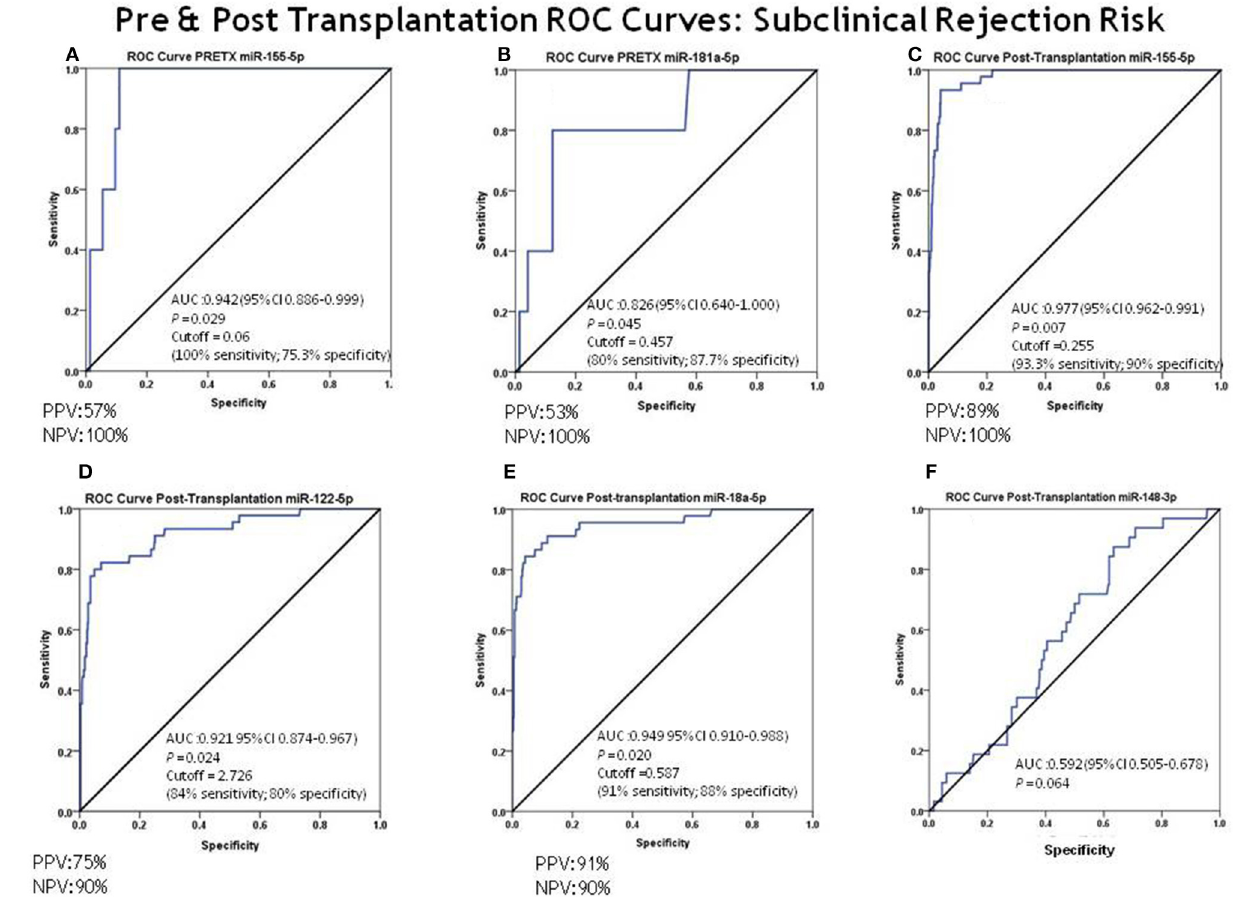
FIGURE 4 | ROC curve analysis for discrimination between subclinical rejectors (SCRs) and non-rejectors. The ROC curve analysis for discrimination between patients with SCR and non-rejectors for each miRNA was evaluated. (A) Pre-transplantation miR-155-5p capacity to discriminate between SCR and non-rejectors: AUC = 0.942 (95% CI = 0.886–0.999) and cut-off value = 0.06 (100% sensitivity, 75.3% specificity, PPV = 57% and NPV = 100%); (B) pre-transplantation miR-181a-5p capacity to discriminate between SCR and non-rejectors: AUC = 0.826 (95% CI = 0.640–1.000) and cut-off value = 0.457 (80% sensitivity, 87.7% specificity, PPV = 53% and NPV = 100%); (C–F) post-transplantation miRNA capacity to discriminate between SCR and non-rejectors: (B) miR-155-5p AUC = 0.977 (95% CI = 0.962–0.991) and cut-off value = 0.255 (93.3% sensitivity, 90% specificity, PPV = 89% and NPV = 100%); (C) miR-122-5p: AUC = 0.921 (95% CI = 0.874–0.967) and cut-off value = 2.726 (84% sensitivity, 80% specificity, PPV = 75% and NPV = 90%); (D) miR-181a-5p: AUC = 0.949 (95% CI = 0.910–0.988) and cut-off value = 0.587 (91% sensitivity, 80% specificity, PPV = 91% and NPV = 90%); (E) miR-148-3p: AUC = 0.592 (95% CI =